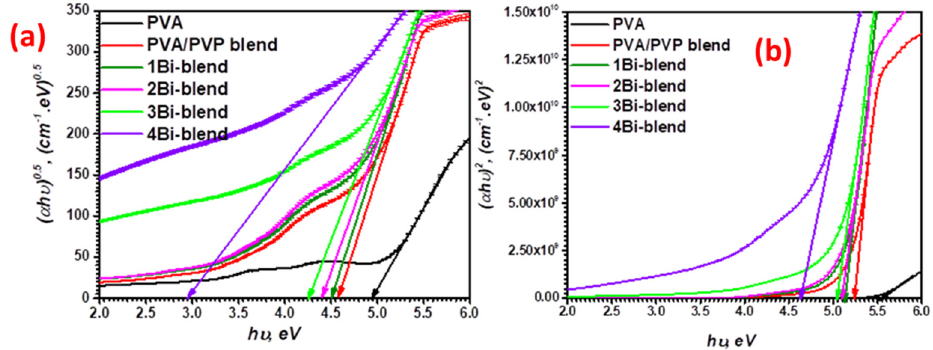
Figure 8. Indirect ( a ) and direct ( b ) optical energy band gaps of pristine PVA, PVP/PVA blend, and Bi-blend hybrid films. Table 1. Absorption edge, Urbach energy, and optical bandgap of Bi-blend hybrid films.